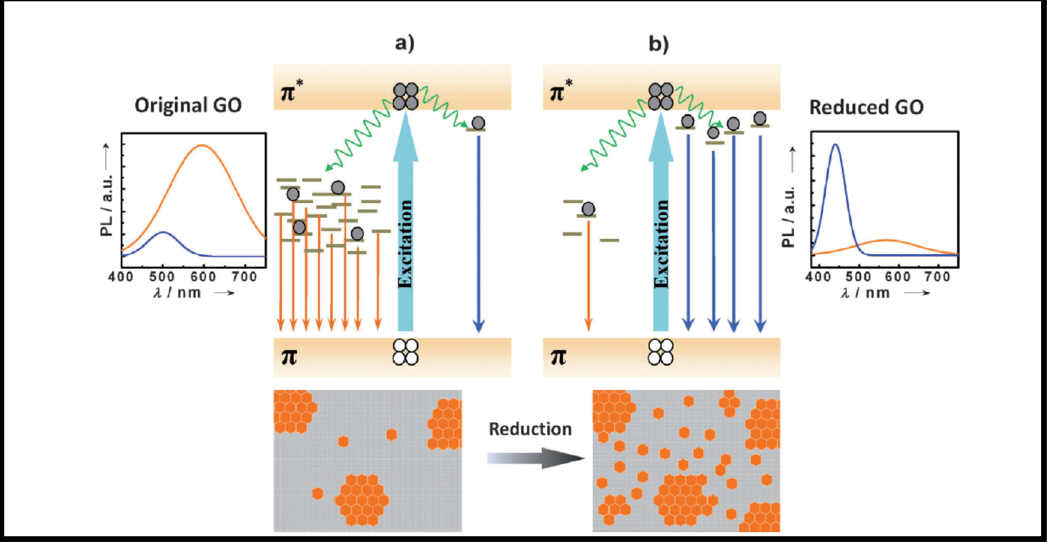
Figure 10: Proposed PL emission mechanisms of ( a ) the predominant IP1 emission in GO from disorder - induced localized states, ( b ) the predominant IP2 emission in rGO from con fi ned cluster states [ 94 ]